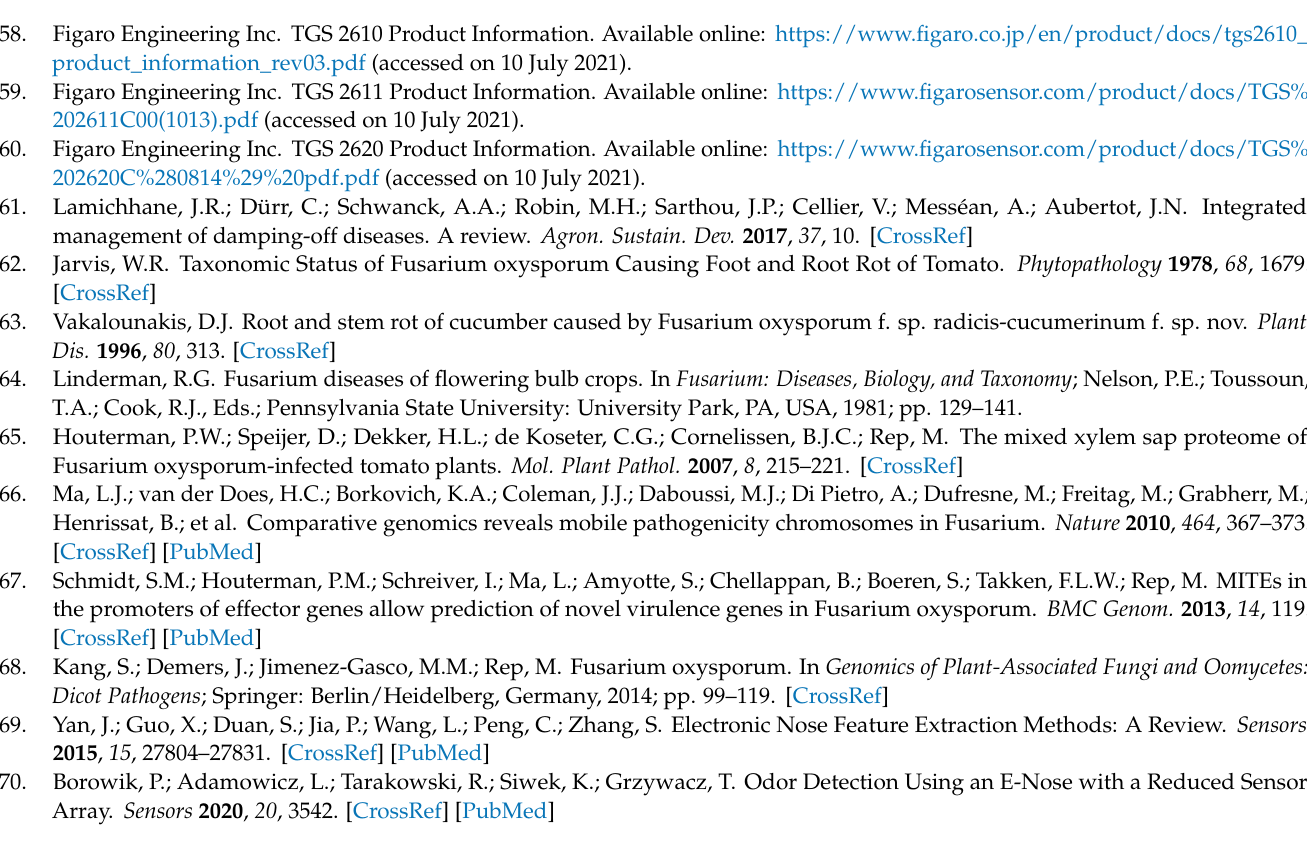
Figaro Engineering Inc. TGS 2610 Product Information. Available online: https://www.figaro.co.jp/en/product/docs/tgs2610_ Figaro Engineering Inc. TGS 2611 Product Information. Available online: https://www.figarosensor.com/product/docs/TGS% Figaro Engineering Inc. TGS 2620 Product Information. Available online: